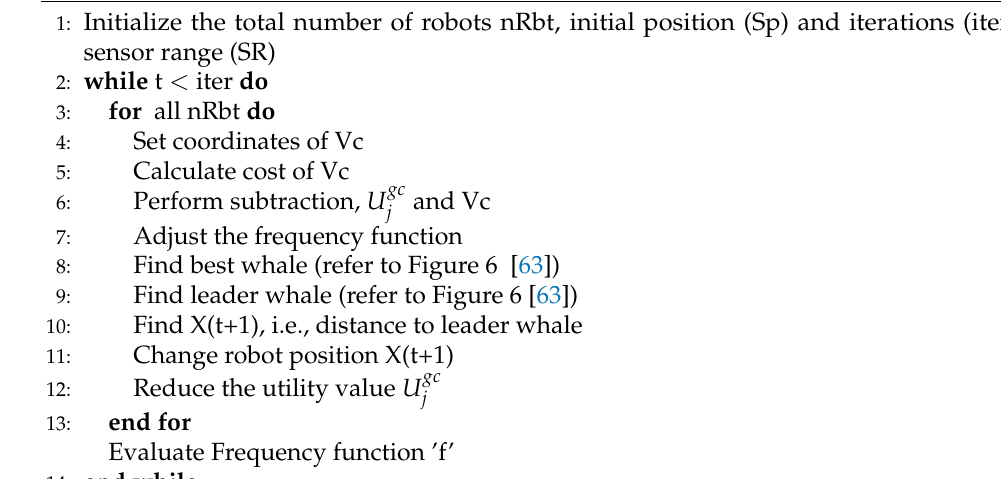
Algorithm 1 Coordinated Multi-robot exploration with WOA.